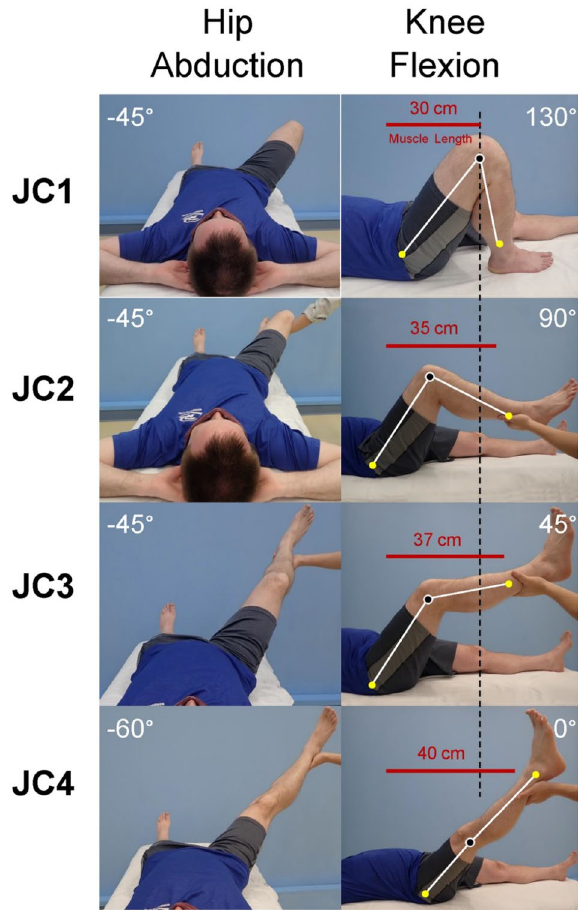
Figure 7. Simulation of the four intraoperative joint configuration (JC) used during data collection. The first column shows hip abduction and the second column shows knee flexion. Hip flexion was 60°. Muscle length increases from 30 to 40 cm from JC1 to